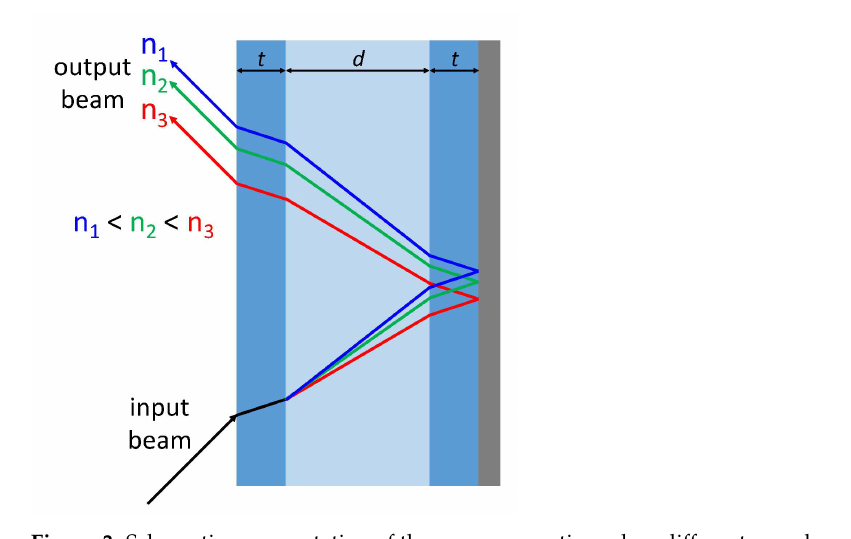
Figure 3. Schematic representation of the sensor operation when different samples with increasing RI are considered in the